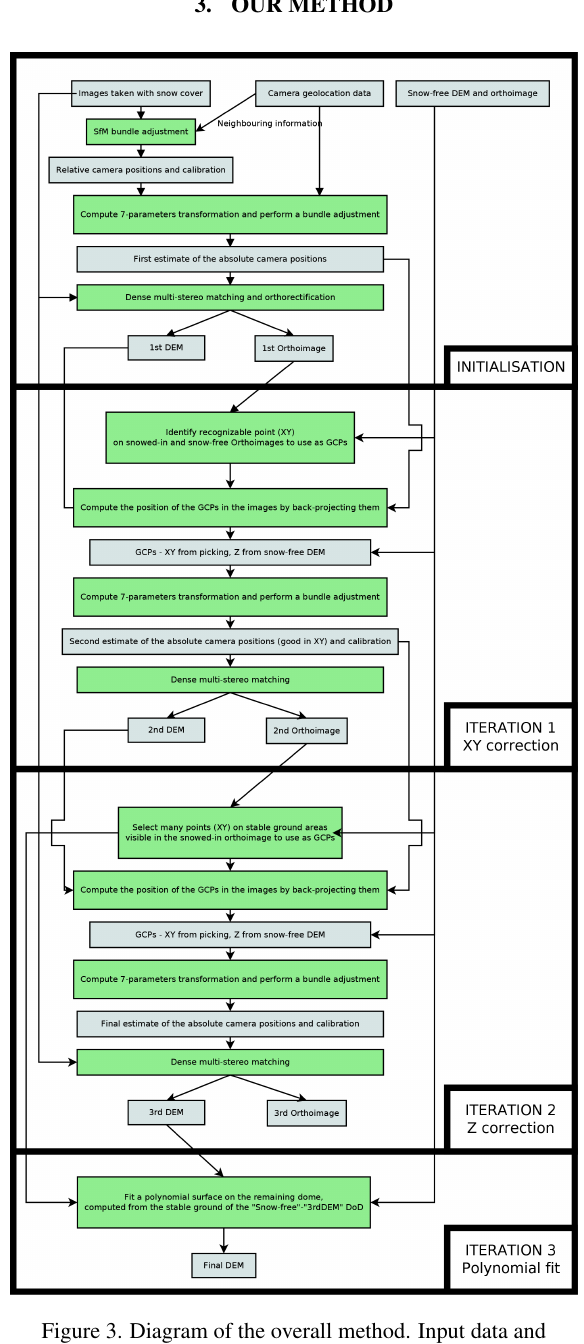
Figure 3. Diagram of the overall method. Input data and products are in grey and processes in